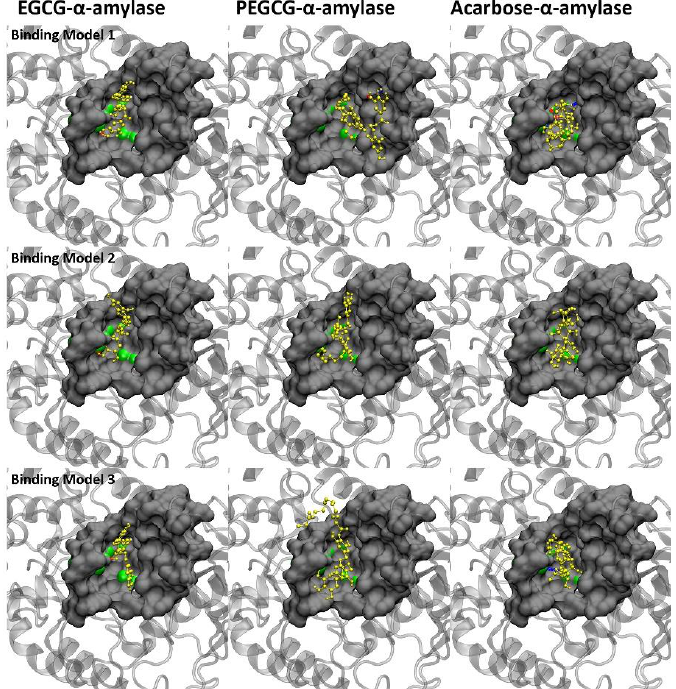
Figure 4. Top 3 predicted binding models of the ligands with α-amylase. Protein is shown in silver in the cartoon model. Drugs are shown in yellow. The catalytic sites are displayed in green. The ligand molecules are represented in yellow. Amino acids in contact are displayed in the surface model. The red and blue dotted lines stand for hydrogen bonds. Table 6. Binding overview of the ligands with α-amylase.